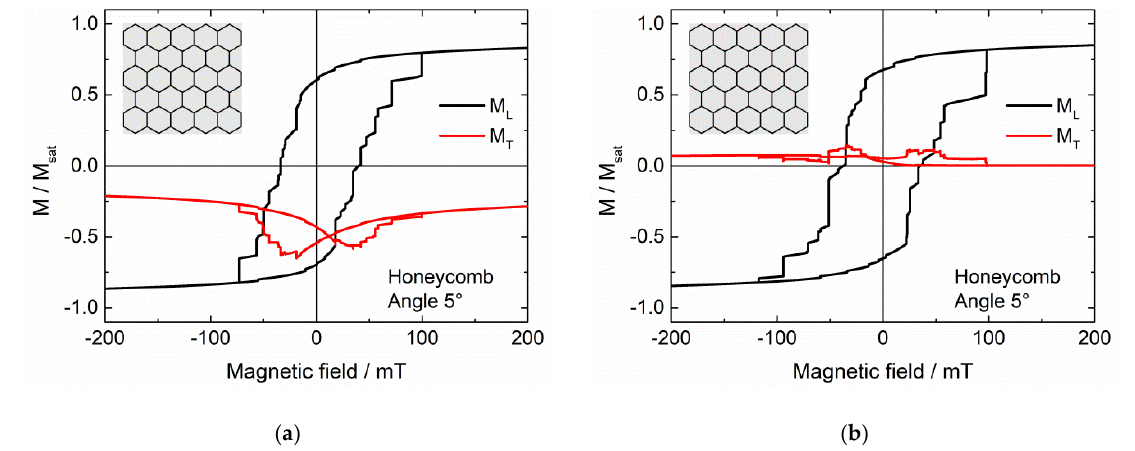
Figure 5. ( a ) Longitudinal and transverse hysteresis loops M L and M T , simulated for a hexagonal tessellation (cf. insets), ( a ) after setting a large magnetic field of 5 T; ( b ) starting from zero field.